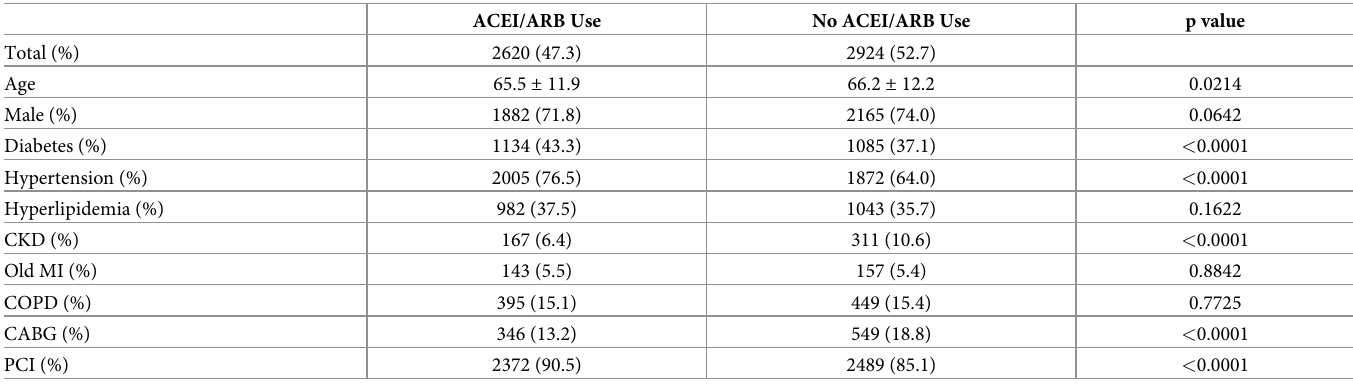
Table 5. Factors associated with ACEI/ARB use at 12